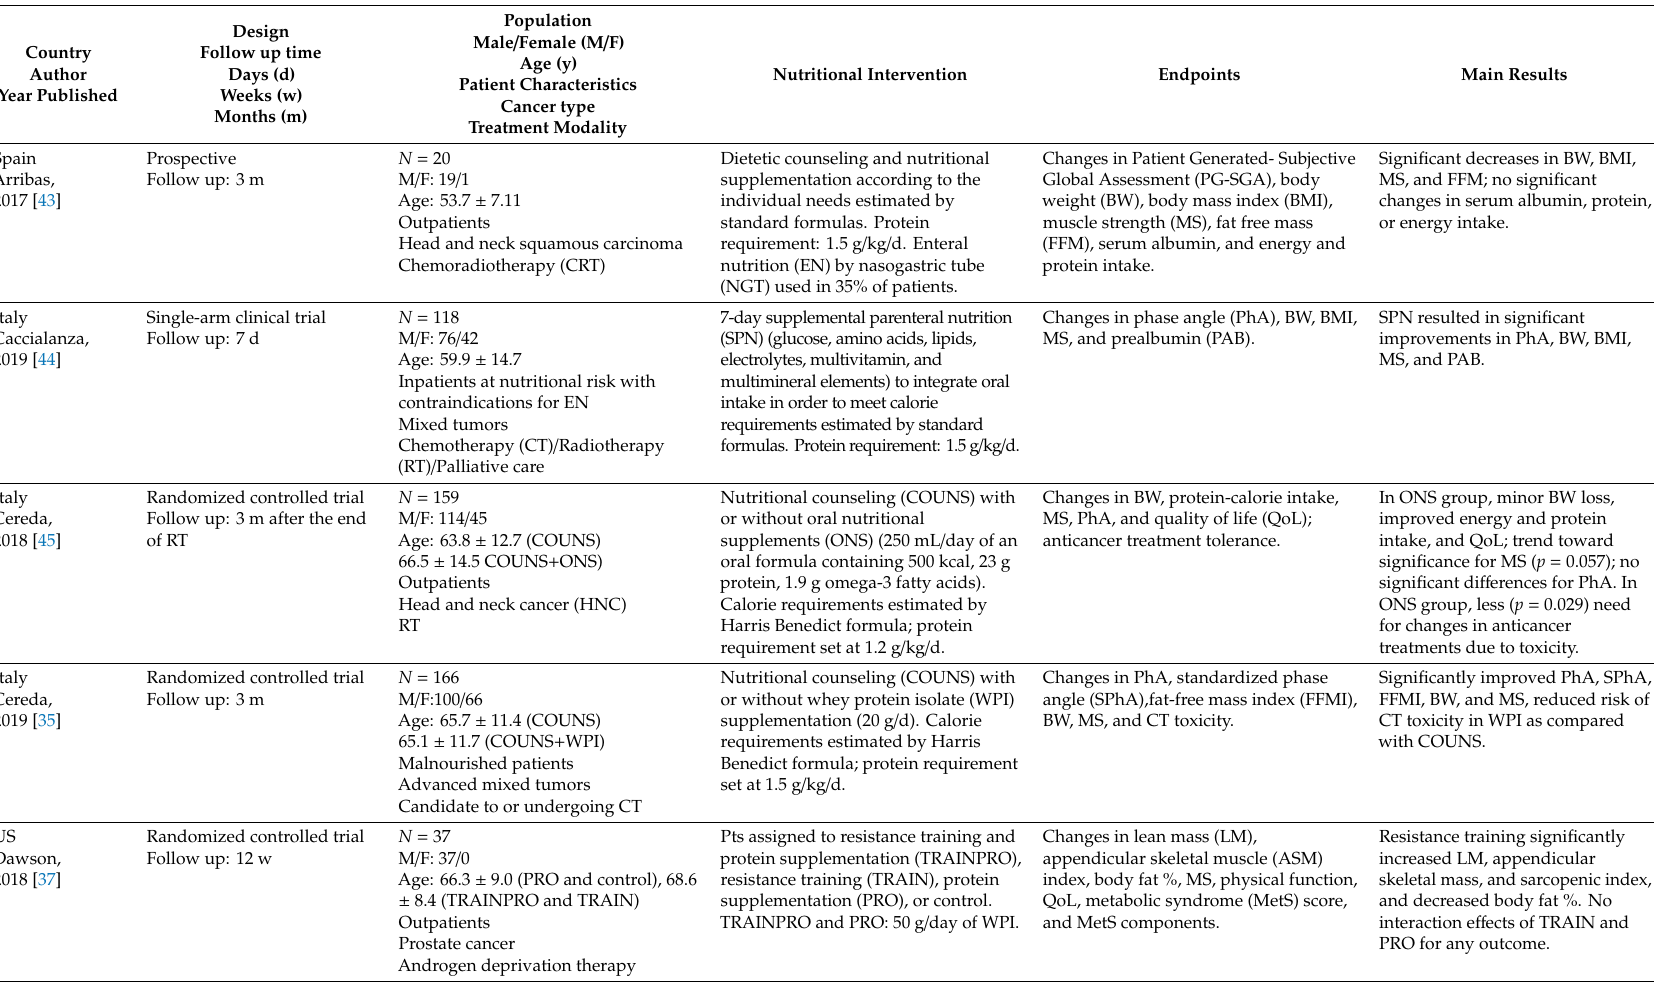
Table 2. Summary of main characteristics of the studies included in the